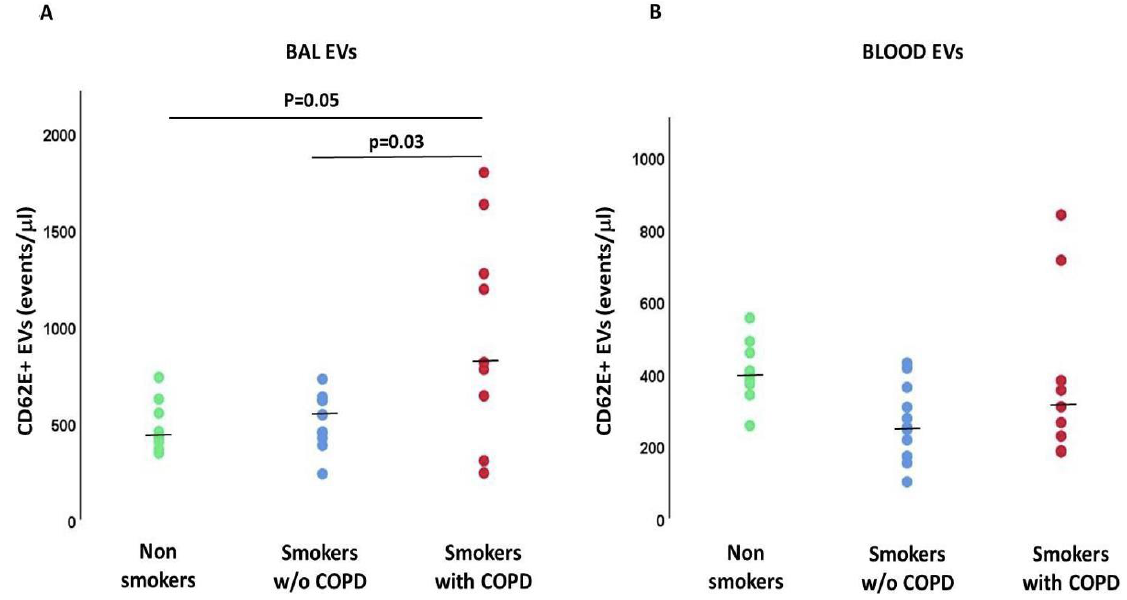
Figure 4. Endothelial activated-derived EVs (CD62E+ events/μ L) in BAL ( A ) and Blood ( B ). p values in the figure represent the results of Mann-Whitney U tests. Kruskal-Wallis test: p < 0.001 for BAL EVs. Kruskal-Wallis test: p = NS for Blood EVs.